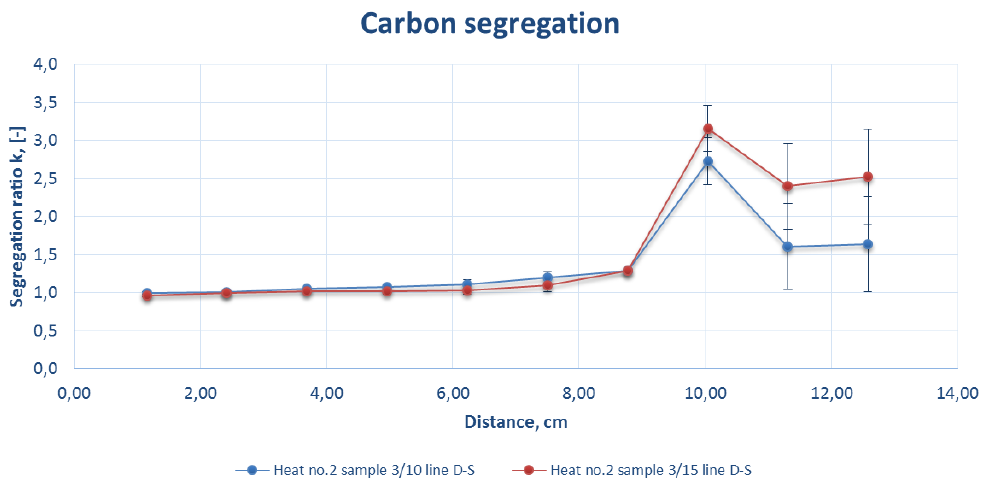
Figure 10. Comparison of the carbon segregation ratio for the sample DS line of strand 3 at a casting speed of 2.5 m/min (heat number 2).